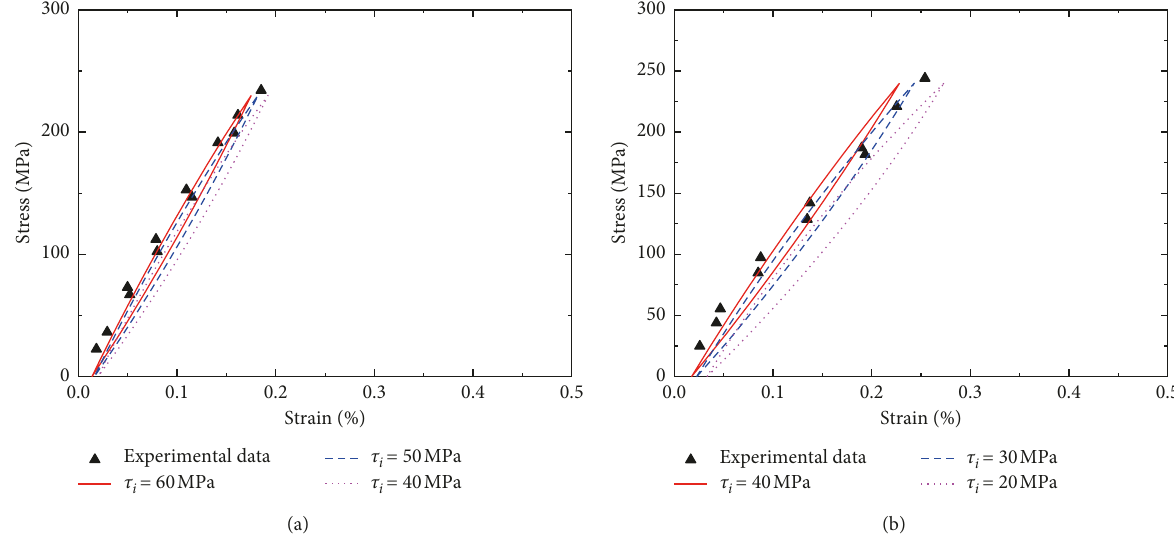
Figure 14: The experimental and predicted fatigue hysteresis loops of 2D Tyranno ™ SiC/SiC composite under (a) the fatigue peak stress of σ max � 230MPa for N � 16000 cycles and (b) the fatigue peak stress of σ max � 240MPa for N � 85